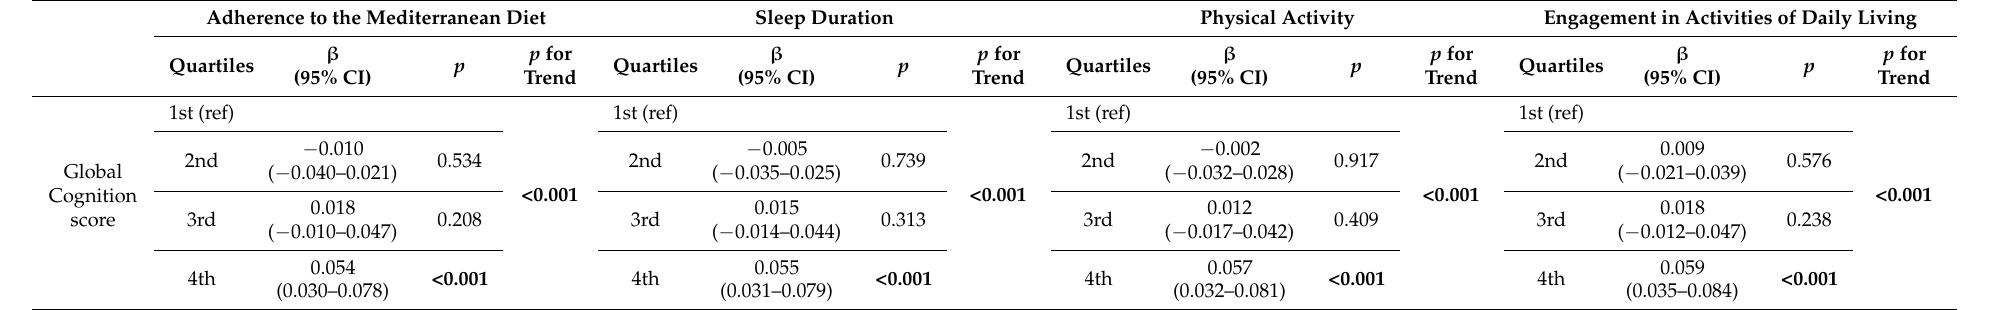
Table 4. Results from Generalized Estimating Equations assessing the associations between quartiles of individual lifestyle factors based on the distribution of the Global Cognition score at baseline for each specific lifestyle factor (independent variables) with differential rates of Global Cognition score over time (dependent variable) in non-demented participants at baseline.